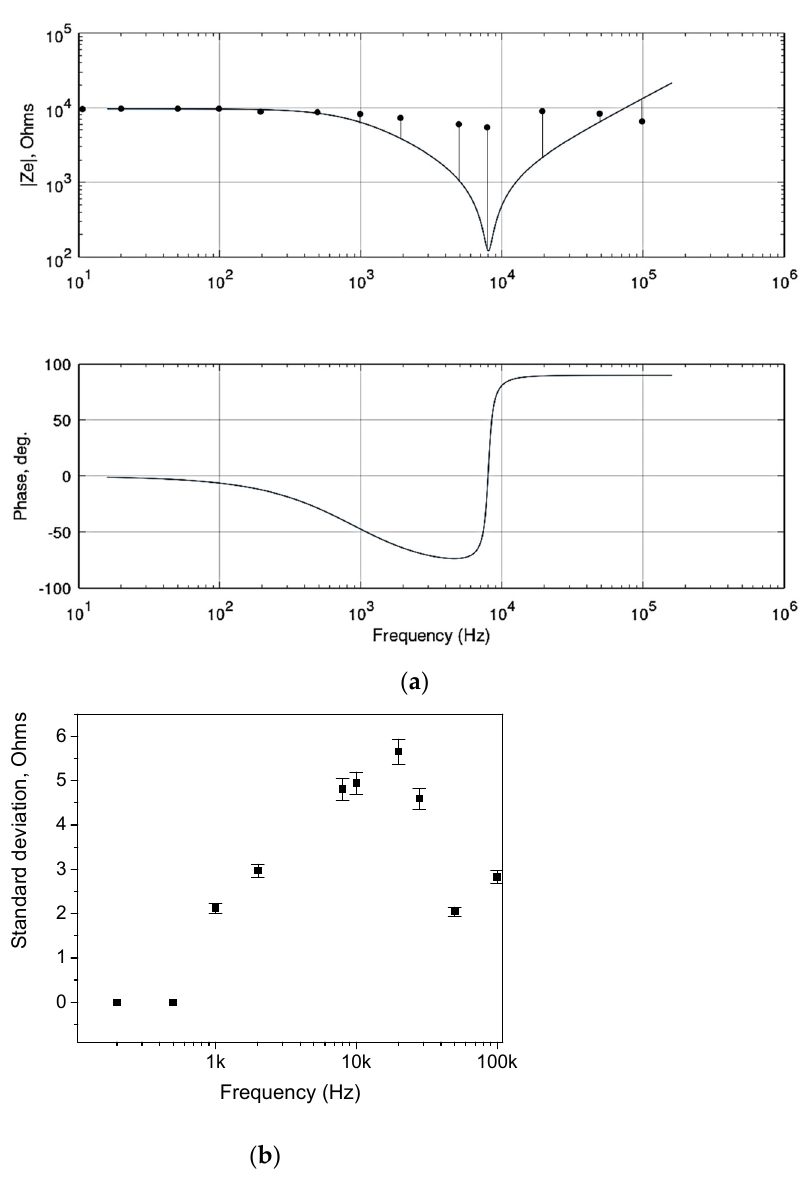
Figure 3. ( a ) Modelled characteristics of the module and the phase of the complex resistance for the equivalent circuit in Figure 2; ( b ) standard deviation between experimental and modelled curves.